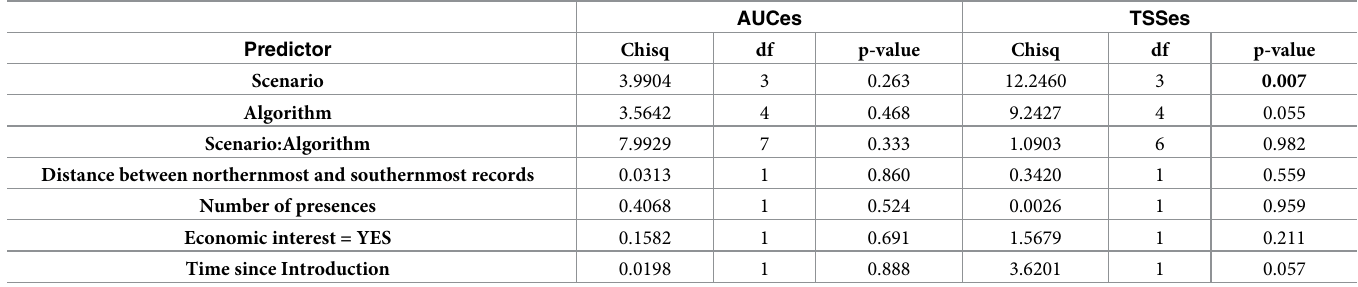
Table 3. Results from Wald test of the linear mixed models applied to analyse the relationship between model performance (measured by TSSes and AUCes effect size values) and the type of scenario, algorithm, their interaction and species’